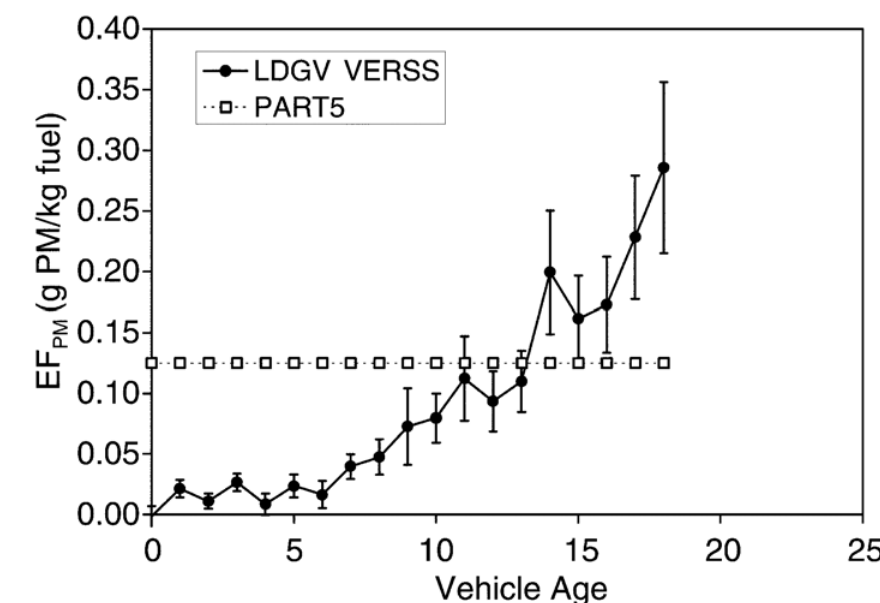
Figure 9. PM emission factors vs. the vehicle age and PART5 numerical simulation